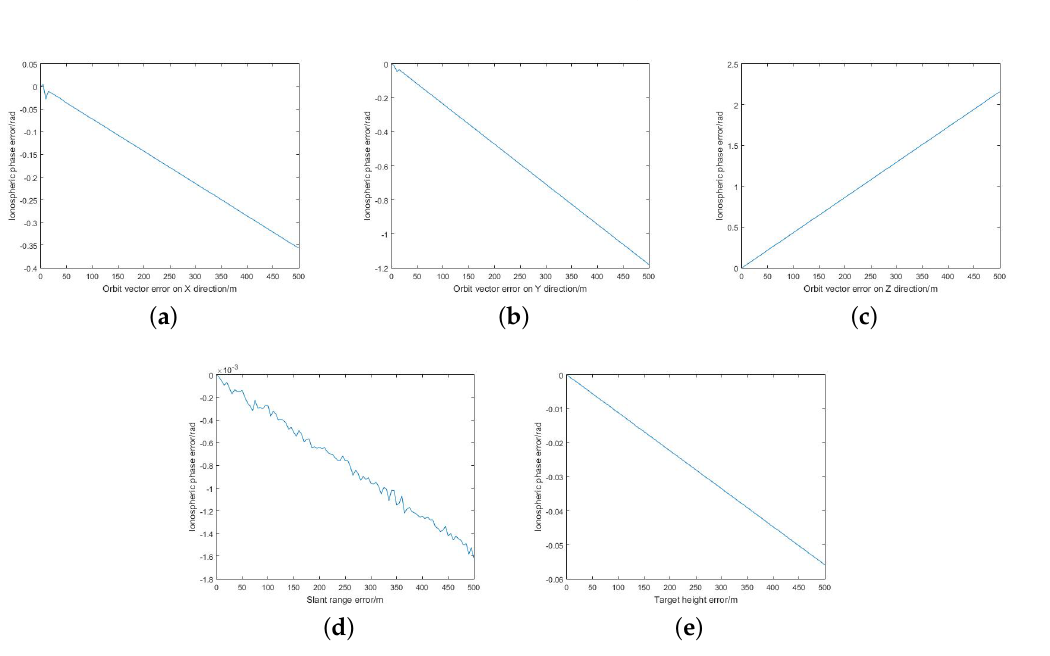
Figure 8. The relationship between error in different factors and ionospheric phase error on 20100623 and 20100808: ( a ) shows ionospheric phase error when error added in X direction of orbit vector. ( b – e ) are ionospheric phase error changing with Y s , Z s , R and h . The phase error is in a linear relationship with orbit error in X direction at around − 7.1101 × 10 − 4 rad/m. Furthermore, slopes are about − 0.0024 rad/m, 0.0043 rad/m, − 3.0637 × 10 − 6 rad/m and − 1.1168 × 10 − 4 rad/m for errors in Y and Z direction, master slant range and target